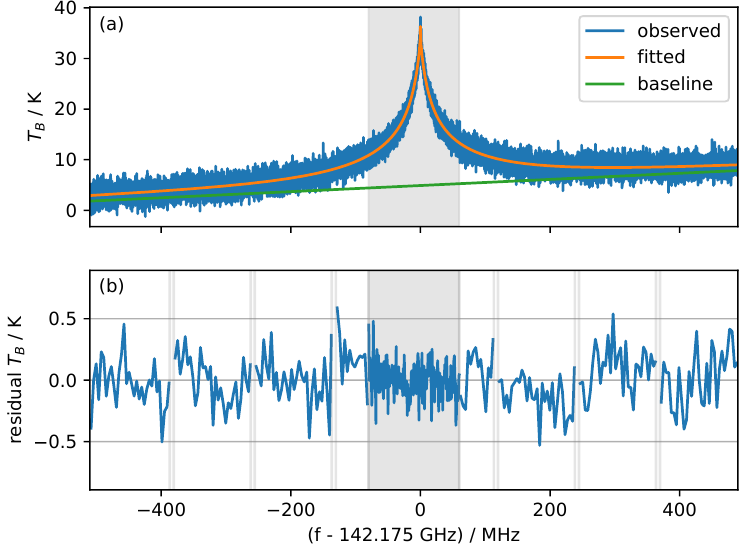
Figure 4. Measured and fitted spectrum for the combined (ChA and ChB) retrieval together with the baseline estimation ( a ). Residuals ( b ) are binned (64 FFTS channels), for each part separately. The spectral region from ChA is indicated by the gray area, and vertical gray lines indicate the boundaries of individual